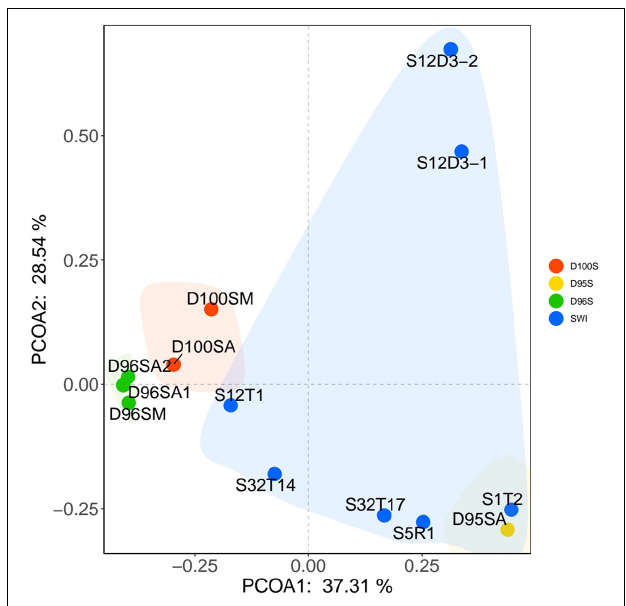
FIGURE 4 | The principal component analysis (PCoA) analysis of microbial communities. The PCoA analysis was performed using the microbial communities at family level. The community structures were based on the classification of 16S miTags (D100SM, D96SM, and the other SWIR reference